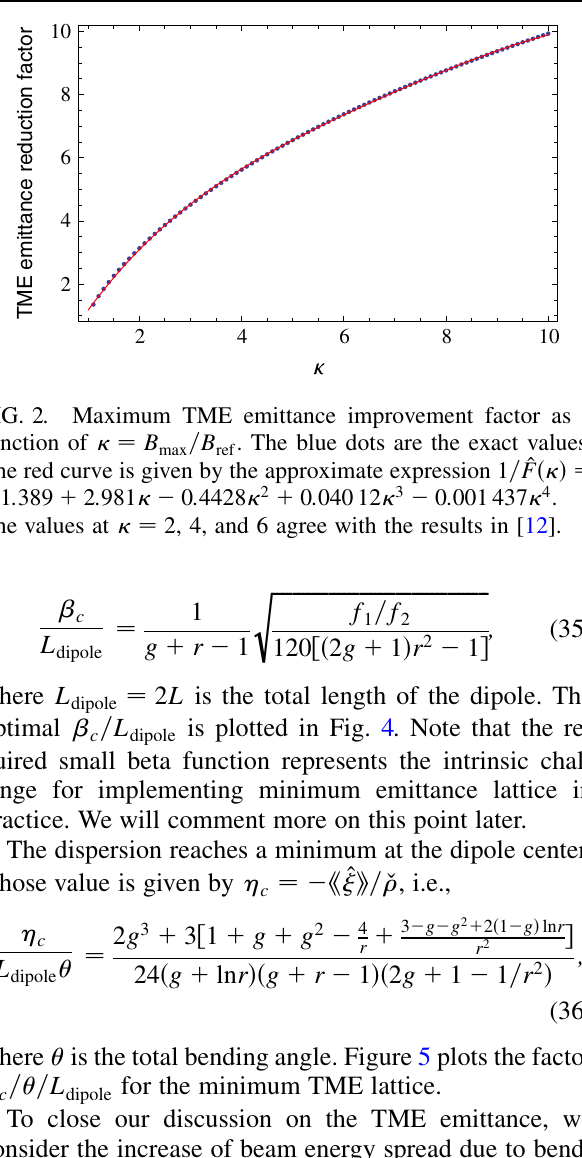
=B =(cid:5) and r ¼ (cid:5) . The obvious ridge max ref max 0